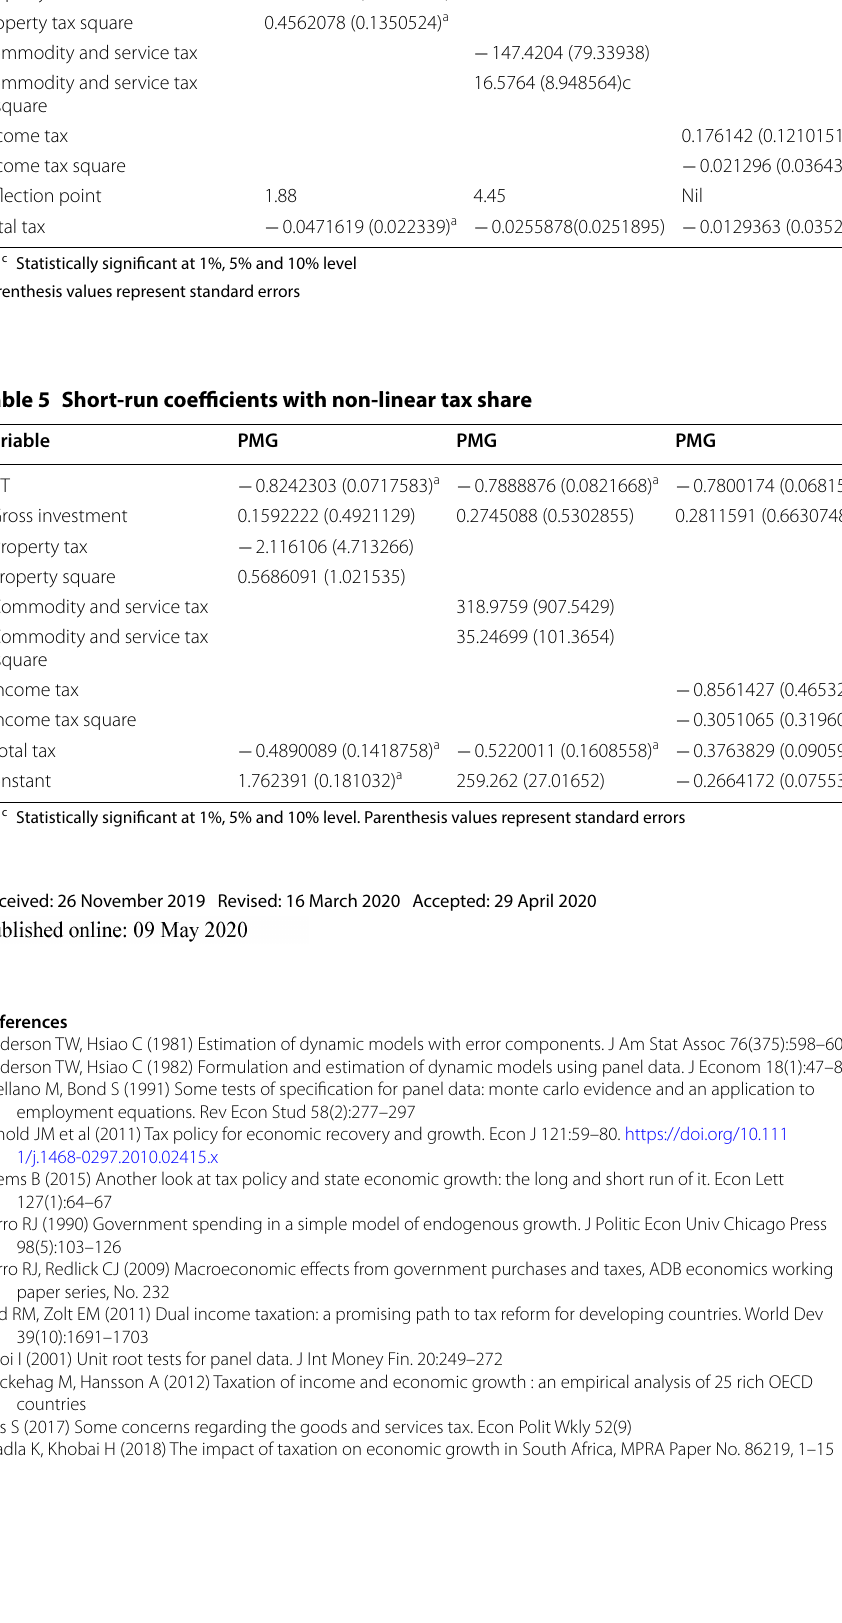
Table 4 Long-run coefficients with non-linear tax share Variable